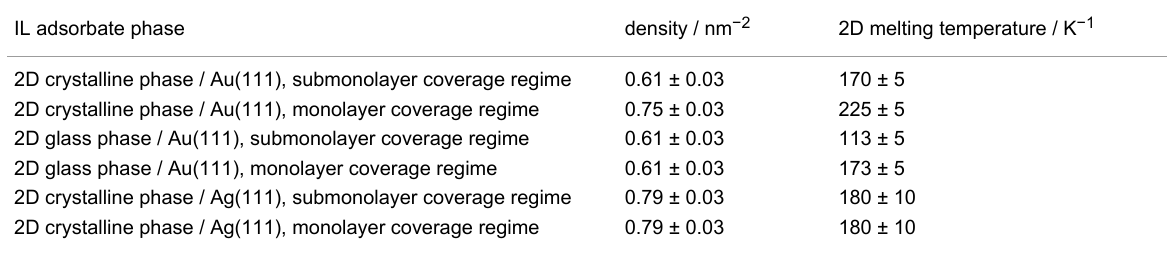
Table 1: Summary of the adsorbate densities and melting temperatures of the adlayer phases found on Ag(111) and Au(111). IL adsorbate